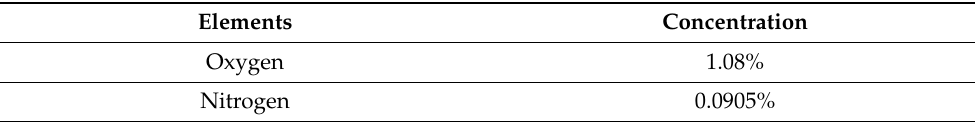
Table 5. Results obtained with the Eltra combustion analyser.